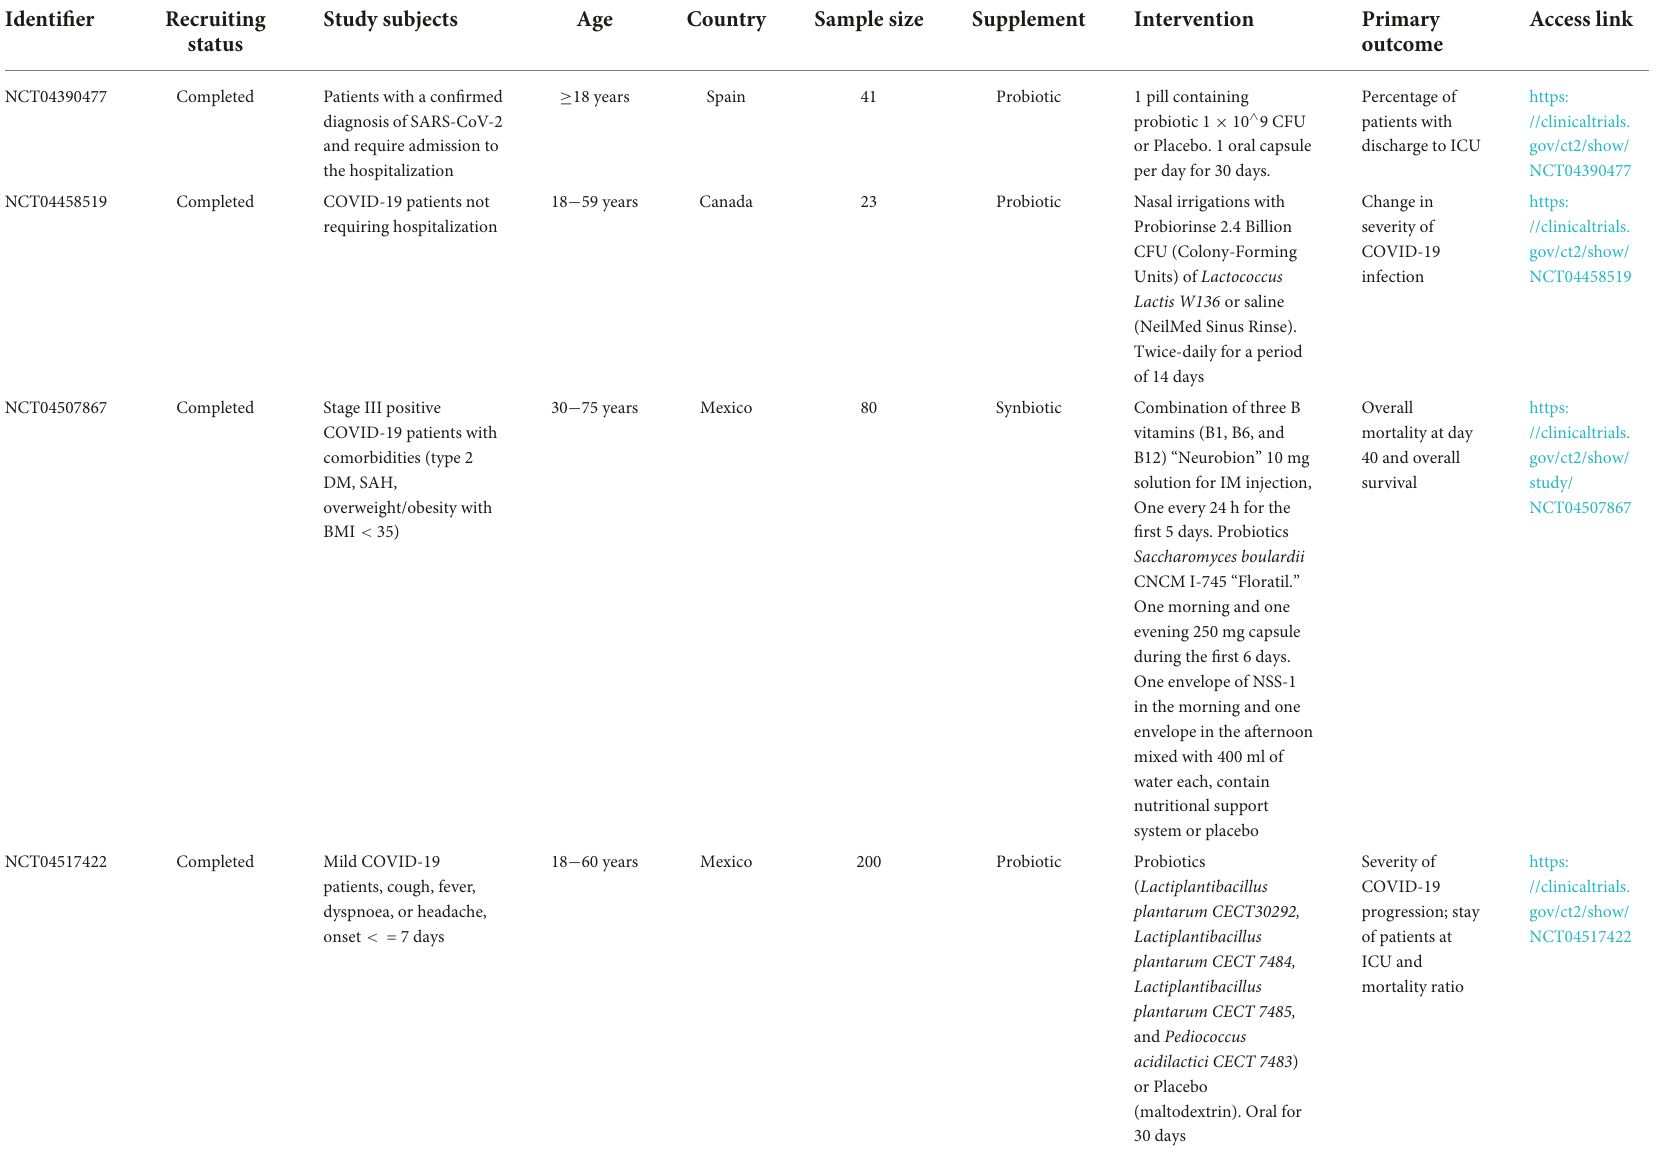
TABLE 3 Several clinical studies of microecological intervention in